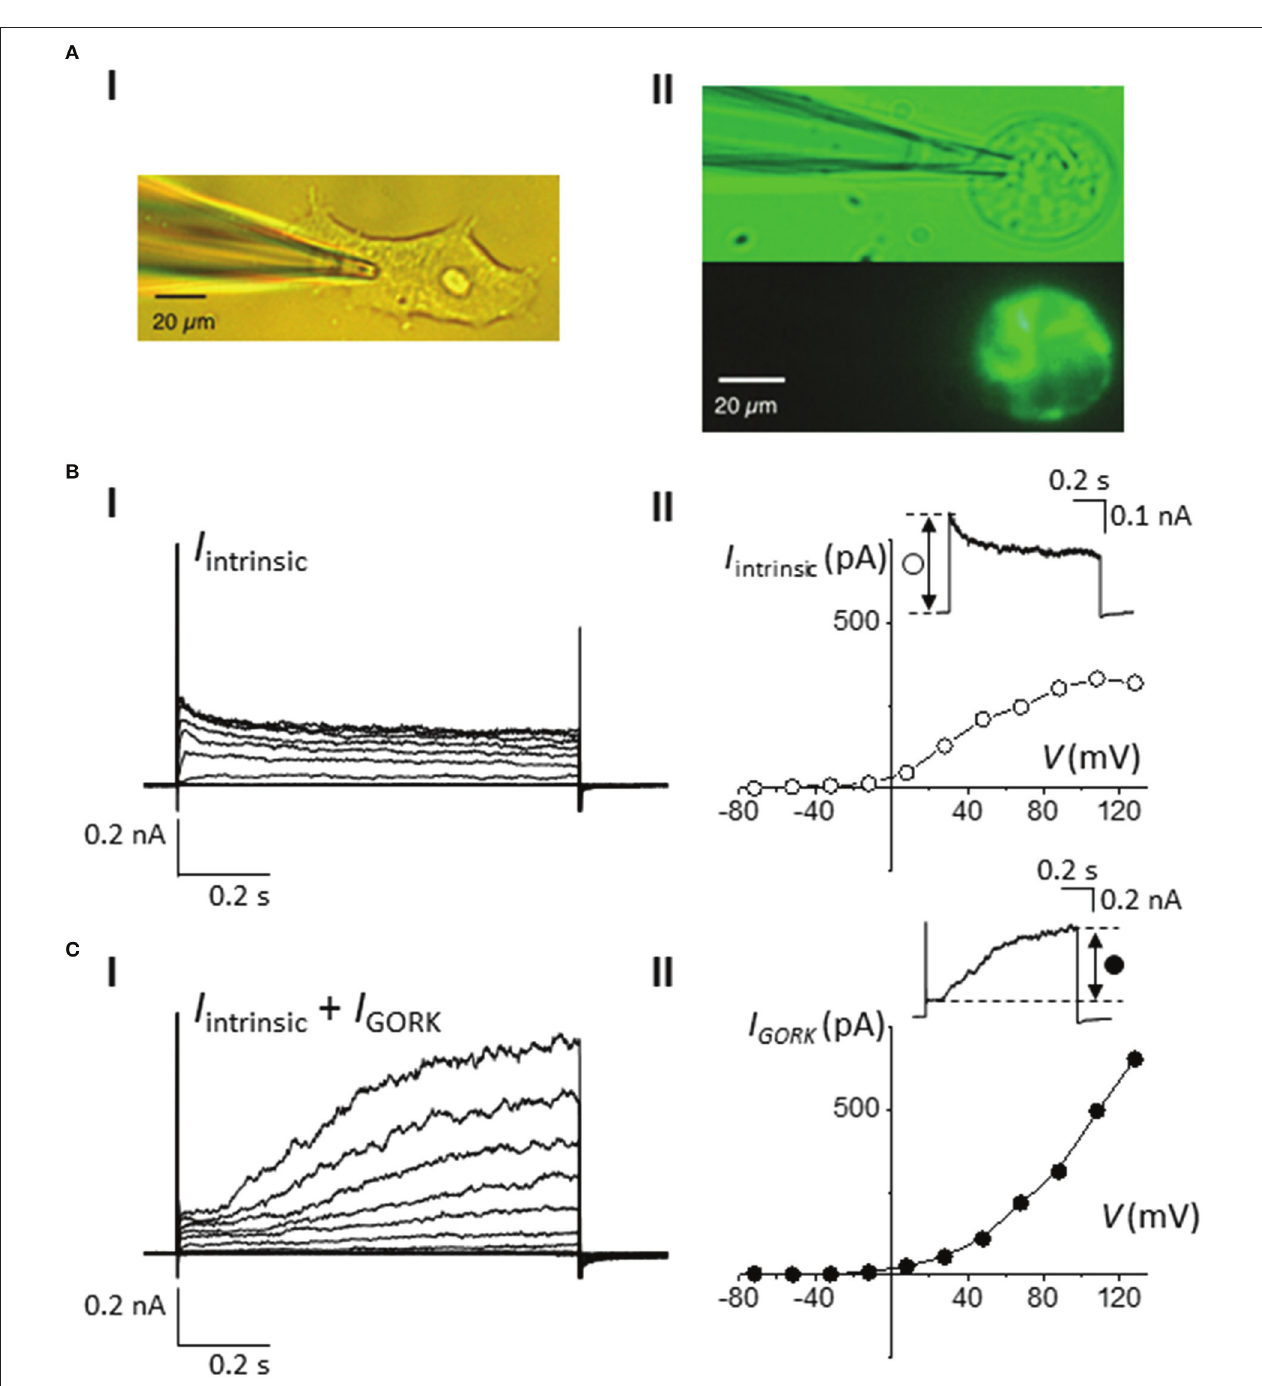
FIGURE 2 | Whole-cell current-voltage measurements of AtGORK-EmGFP in 293FT cells. (A) Bright field and fluorescence images of (i) 293FT and (ii) AtGORK-EmGFP —expressing 293FT single cell at 20 × magnification field view (scale bar = 20 µ m). 293FT cells were transfected with 2.5 µ g of Vivid Colors TM pcDNA TM 6.2/EmGFP-DEST Gateway ® expression vector containing the AtGORK insert using Lipofectamine ® 3000 in a “reverse” format (see Section Procedure for description). (B) Voltage- and time-dependent (i) and I-V plot (ii) properties of the intrinsic K + channels in HEK-293 cells in response to a series of depolarizing square pulse (from a holding potential, H V = − 52mV in 20mV increments). Inset: A current showing the fast activation and relatively slower inactivation kinetics of intrinsic K + currents upon depolarization. (C) Whole-cell patch-clamp recordings (i) and I-V plot (ii) of intrinsic K + and AtGORK channels currents, starting from H V = − 52mV in 20mV increments in AtGORK-EmGFP —expressing 293FT single cell. Inset: A representative current demonstrating the slowly activating outward currents of AtGORK upon depolarization.